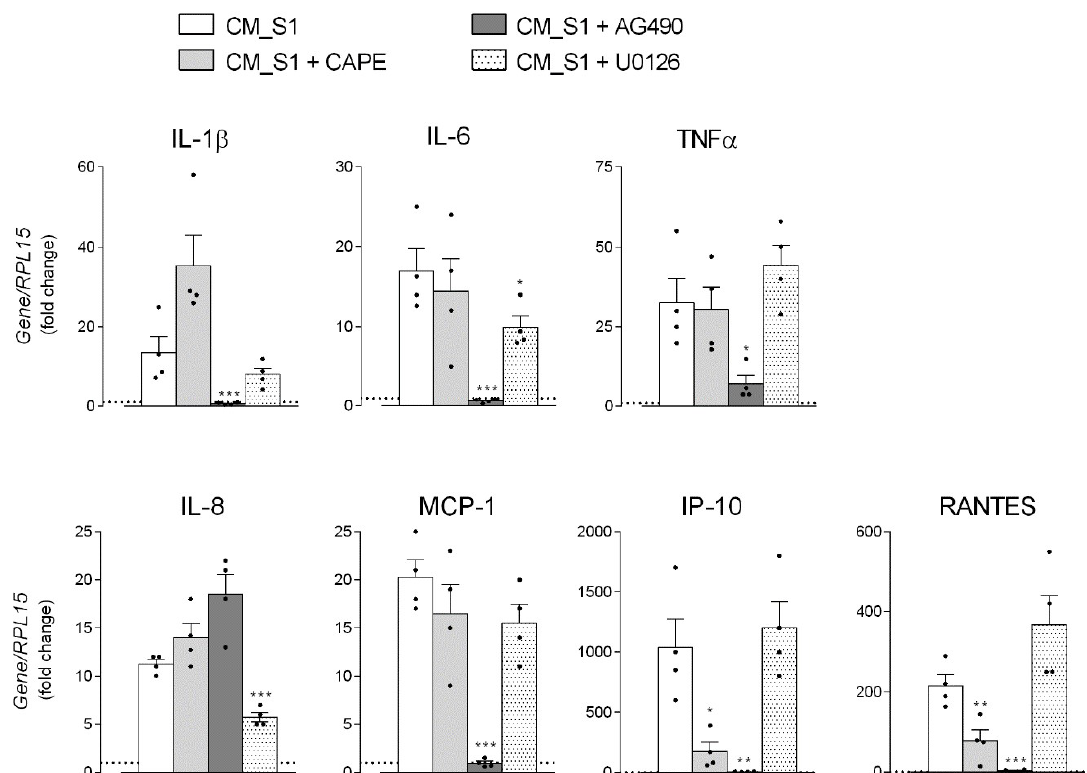
Figure 4. A549 were incubated for 4 h with conditioned medium (CM) from untreated (CM_cont) or S1-treated (CM_S1) monocyte-derived macrophages (MDM), either in the absence or in the presence of the indicated inhibitors, added 30 min before the treatment. The expression of the indicated genes was measured by means of RT-qPCR and calculated relative to CM_cont (=1, dotted line) upon normalization for the housekeeping gene RPL15, as described in Methods. Data are means ± SEM of four determinations, each performed in duplicate. * p < 0.05, ** p < 0.01, *** p < 0.001 vs. CM_S1.